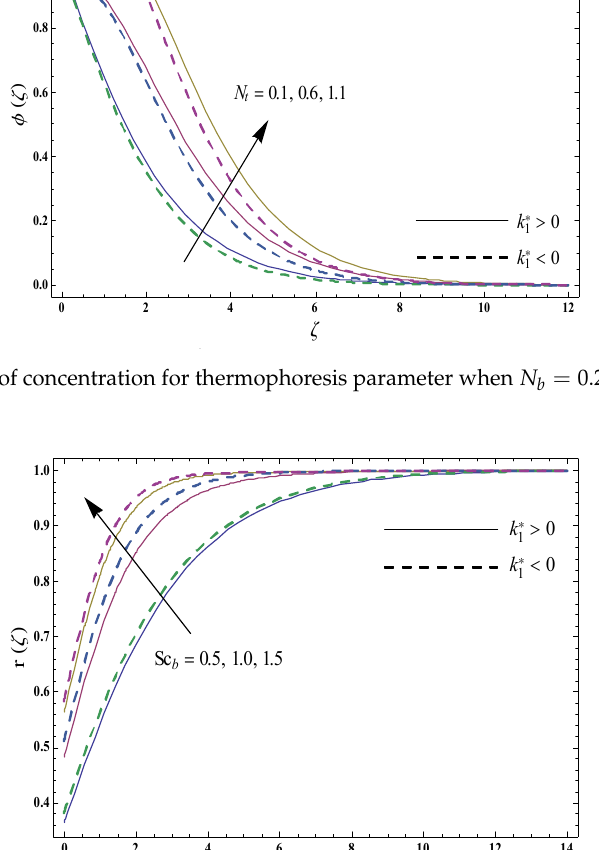
Fig. 10 : Variations of concentration rate for Schmidt number (for heterogeneous- Figure 10. Variations of concentration rate for Schmidt number (for heterogeneous–homogeneous reactions) when K = 0.2, K s = 0.5 and M = = 0  5 and  = 0  2  homogeneous reactions) when  = 0  2   